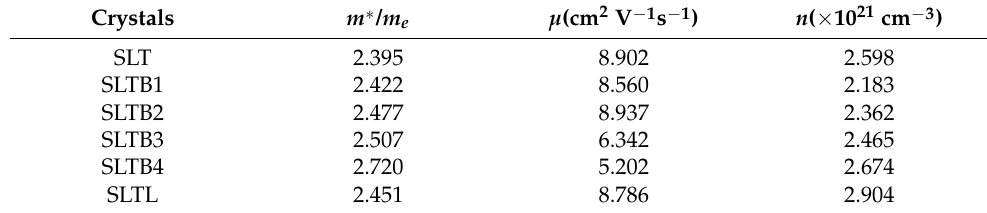
Table 2. m ∗ / m e , µ , n of (Sr 0.889-x La 0.111 Bi x )TiO 2.963 at 300